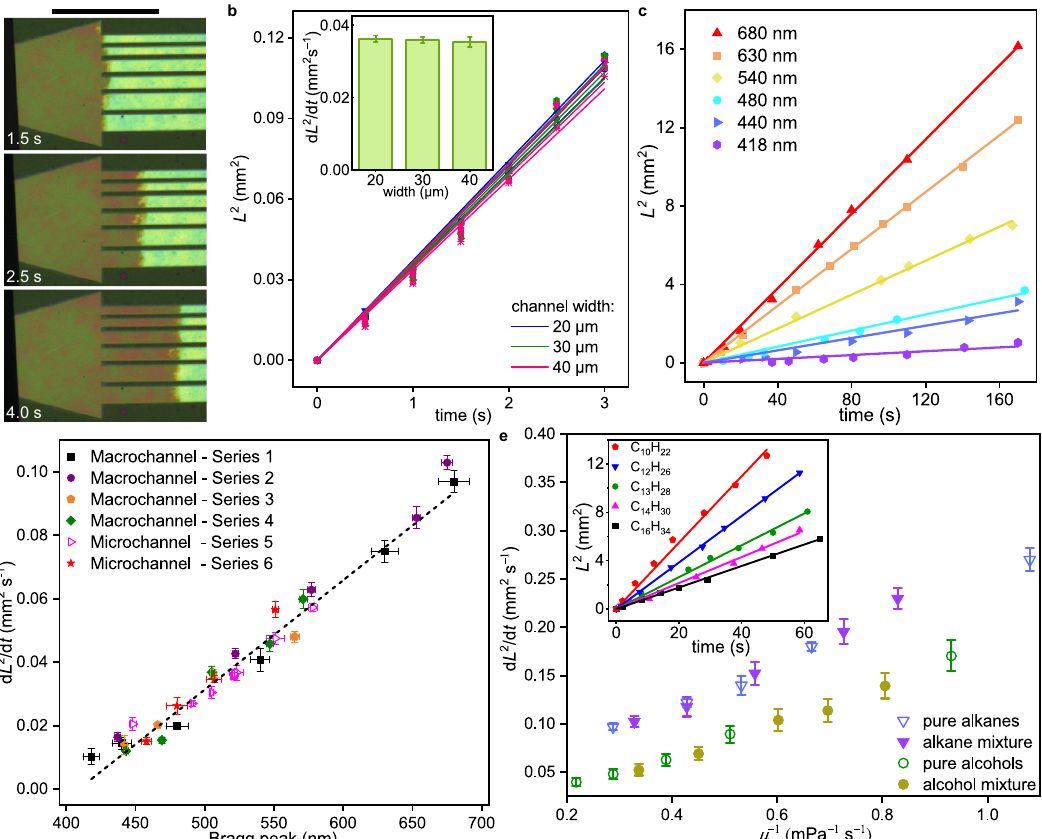
Fig. 3 Flow dynamics of OM channels. a Optical microscope photos showing fl ow in OM channel is independent of extrinsic channel width. Scale bar, 200 μ m. b Flow behaviour in microbars, L 2 versus t . Inset shows statistics of d L 2 /d t versus channel width. Error bars are standard deviation (S.D.) from 4 measurements. c L 2 versus t for OM channels with different Bragg peaks. d Correlation between fl uidic property and structural colour as shown by d L 2 /d t versus Bragg peak location. Optical microscope photos for microchannels are shown in Supplementary Fig. 5. Series 1, 2 are fl ow measurements from 3- mm-width channels; series 3, 4 are fl ow measurements from 5-mm-width channels. Series 5, 6 are fl ow measurements from micron-sized channels (features from 5 to 40 microns). The channels, prepared under different photoinitiator and illumination conditions, are speci fi ed in Supplementary Table 3. Error bars are S.D. across 3 measurements. Liquid is n -hexadecane for ( a – d ). e The dependence of d L 2 /d t on liquid viscosity. In detail, pure alkane refers to n -decane, n -dodecane, n -tridecane, n -tetradecane, and n -hexadecane; alkane mixture refers to the binary mixture of n -decane and n -hexadecane with different mole fractions; pure alcohol refers to ethanol, n -propanol, n -butanol, n -pentanol, and n -hexanol; alcohol mixture refers to the binary mixture of ethanol and n -hexanol with different mole fractions. The calculation of mixture viscosity is presented in Supplementary Tables 4 and 5. Inset shows the L 2 versus t for pure alkanes. The L 2 versus t for alkane mixture, pure alcohols, and alcohol mixture is presented in Supplementary Fig. 7. Error bars are S.D. across 3